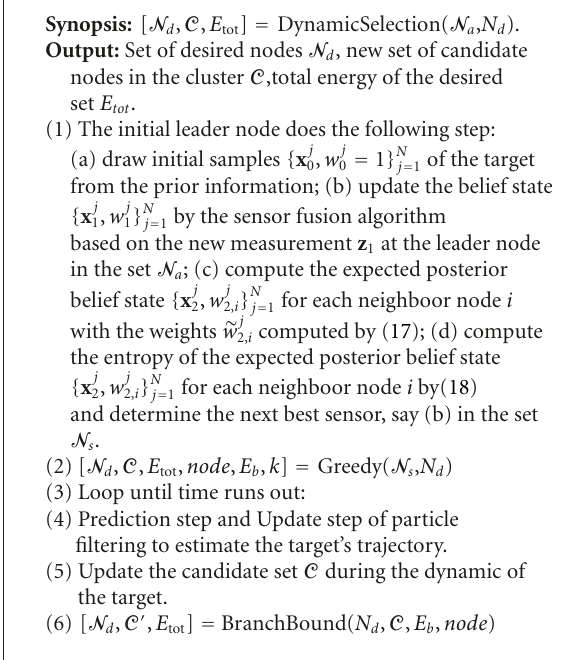
Table 2: Time to process greedy and Kaplan